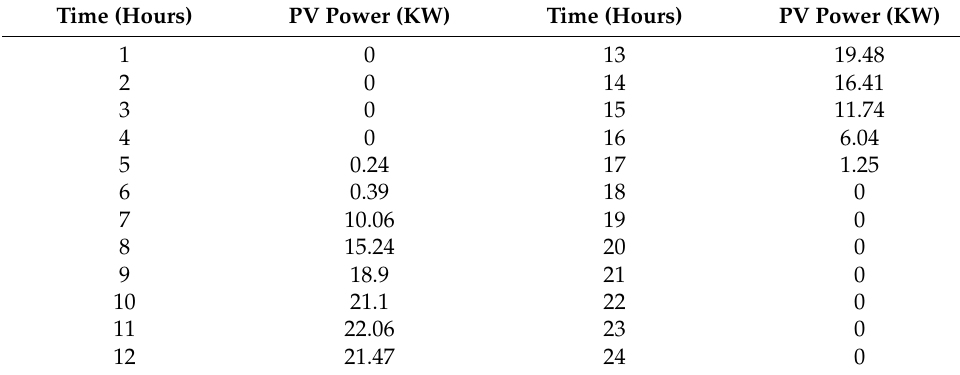
Table 1. PV Power prediction data.